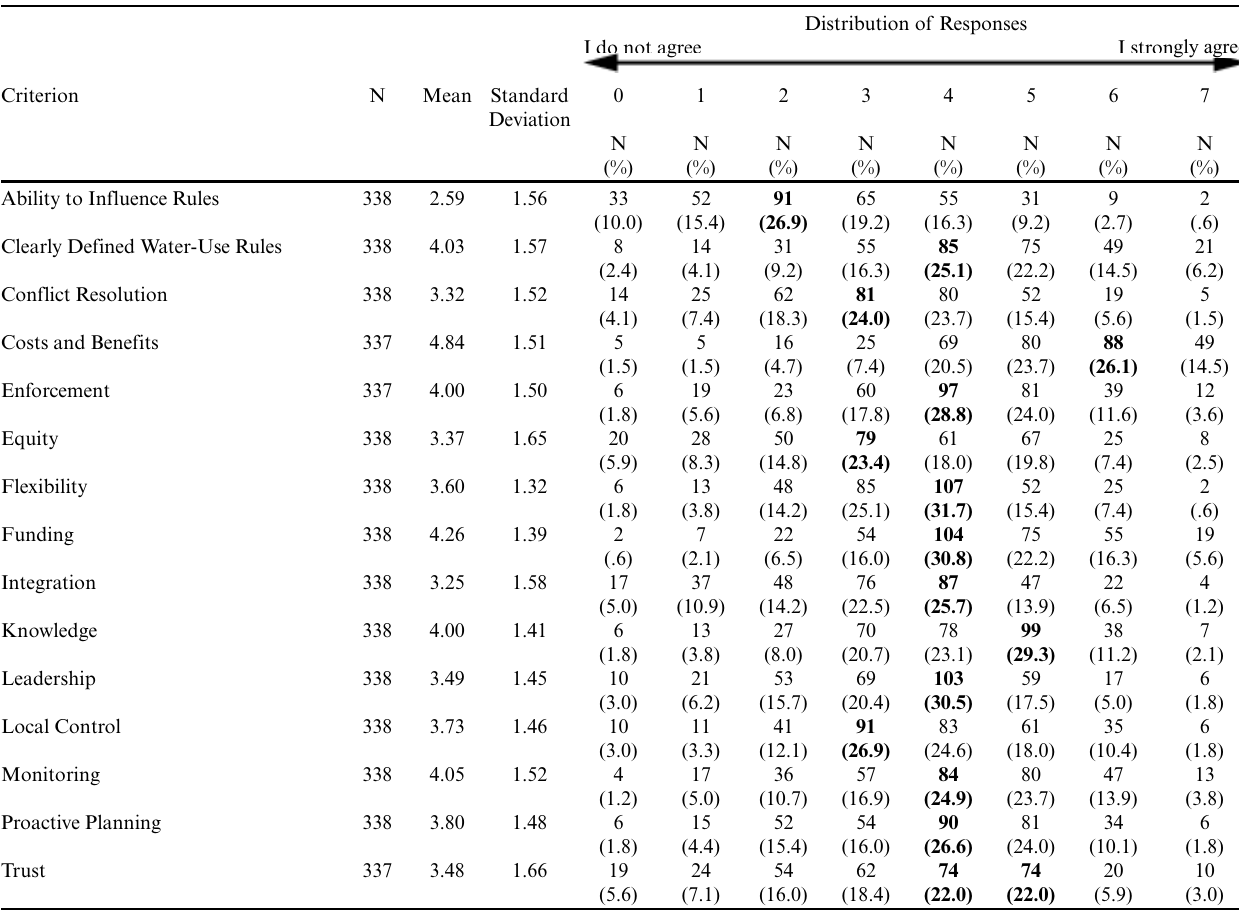
Table 3 . Overall distribution and summary statistics for the successful water management in the Platte River Basin, Nebraska, survey criteria. The highest response rate for each criterion is in